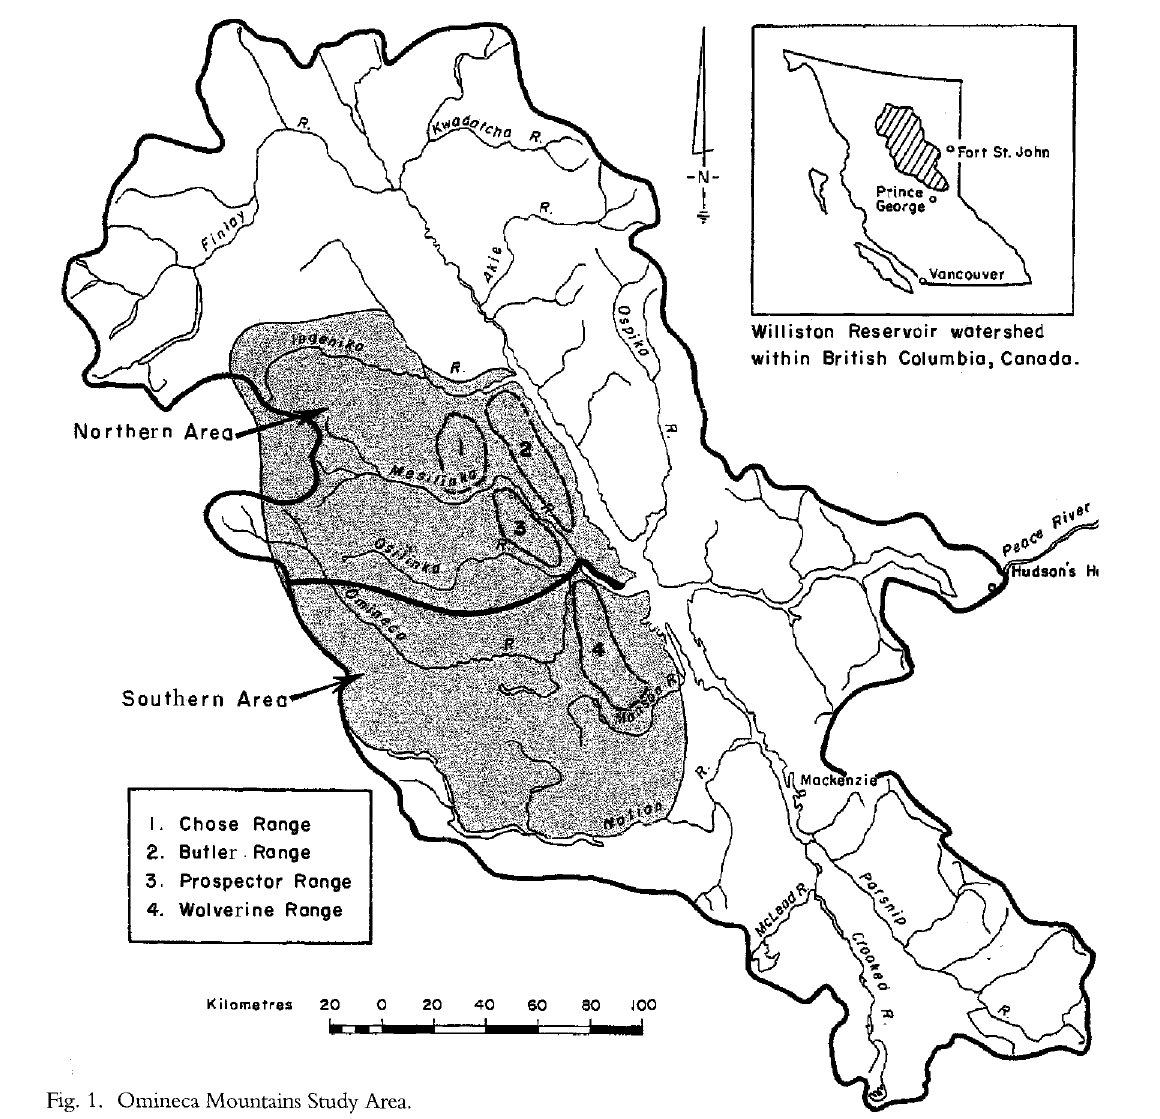
Fig. 1. Omineca Mountains Study